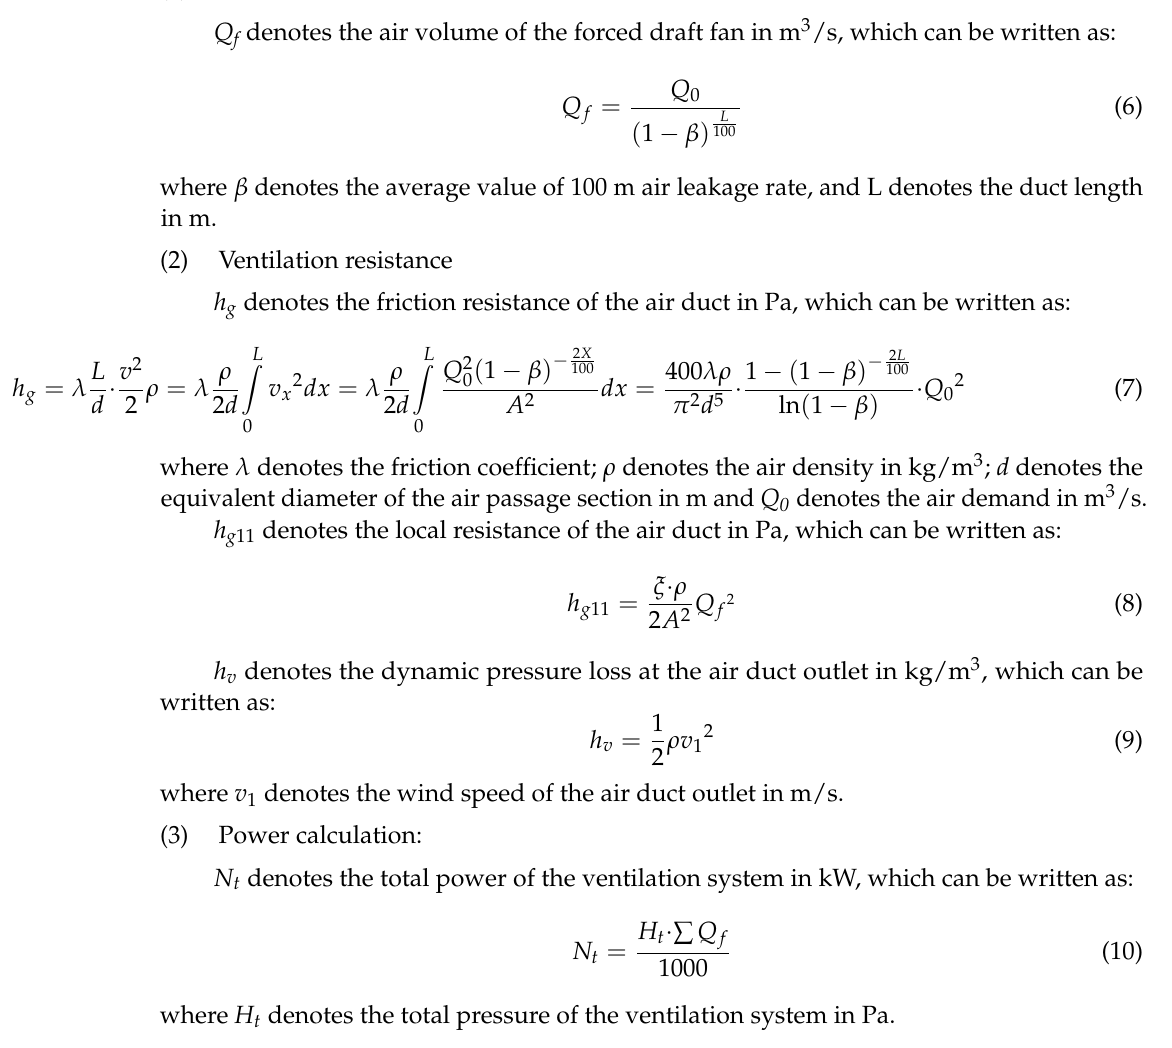
Table 4. Energy consumption of air cabin ventilation system.